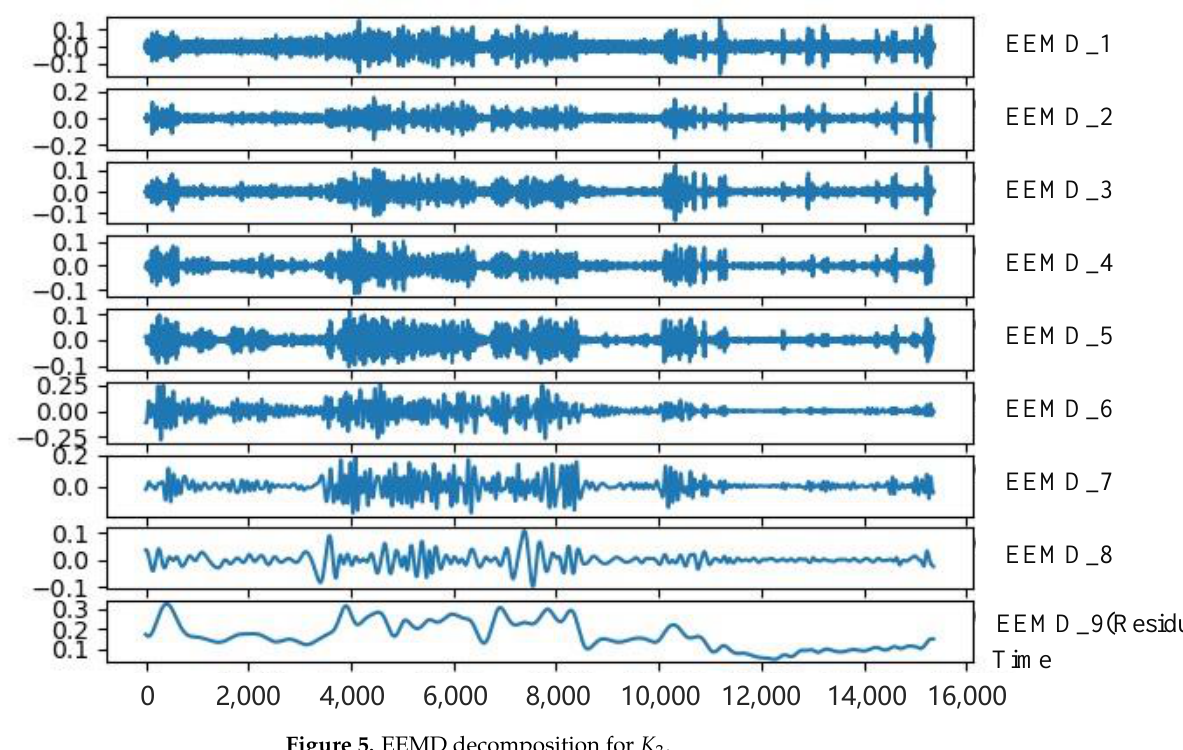
Figure 5. EEMD decomposition for K 3 .